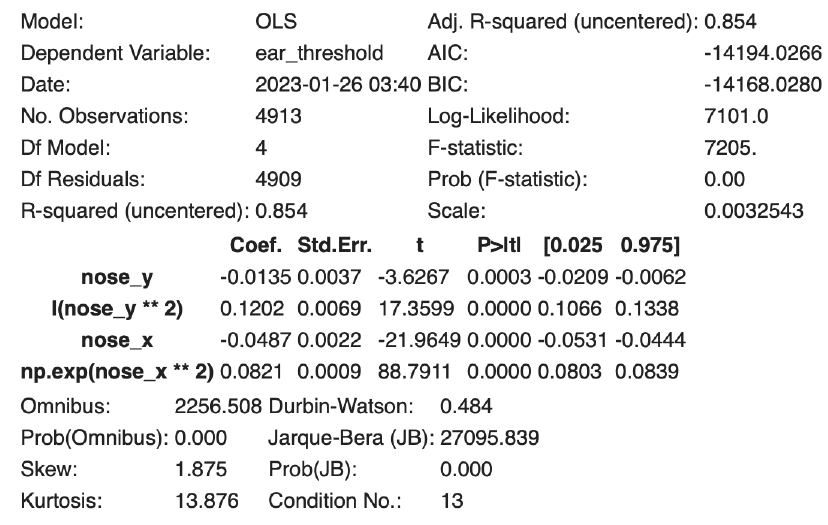
Figure 6. OLS Regression on EAR w.r.t. face orientation (Equation